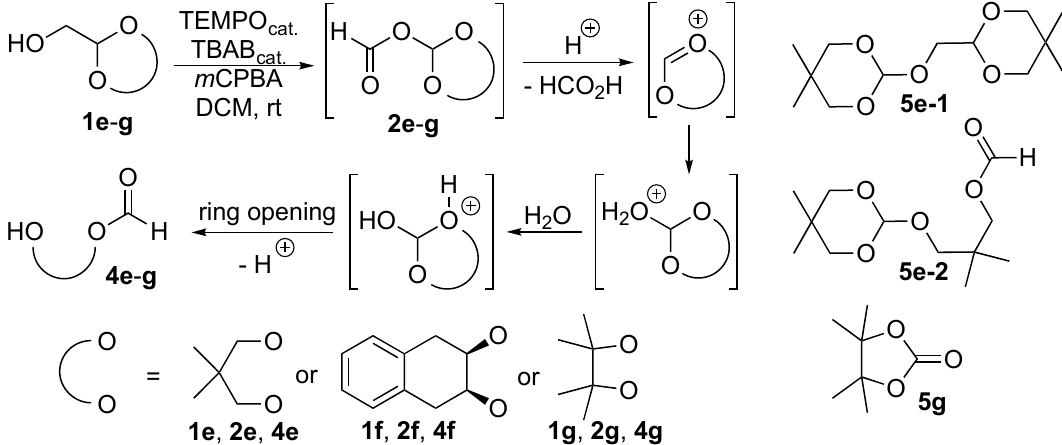
Scheme 6. Domino oxidation of substrates ( 1e – g ) and secondary reactions of the formed dialkoxymethyl carboxylates.